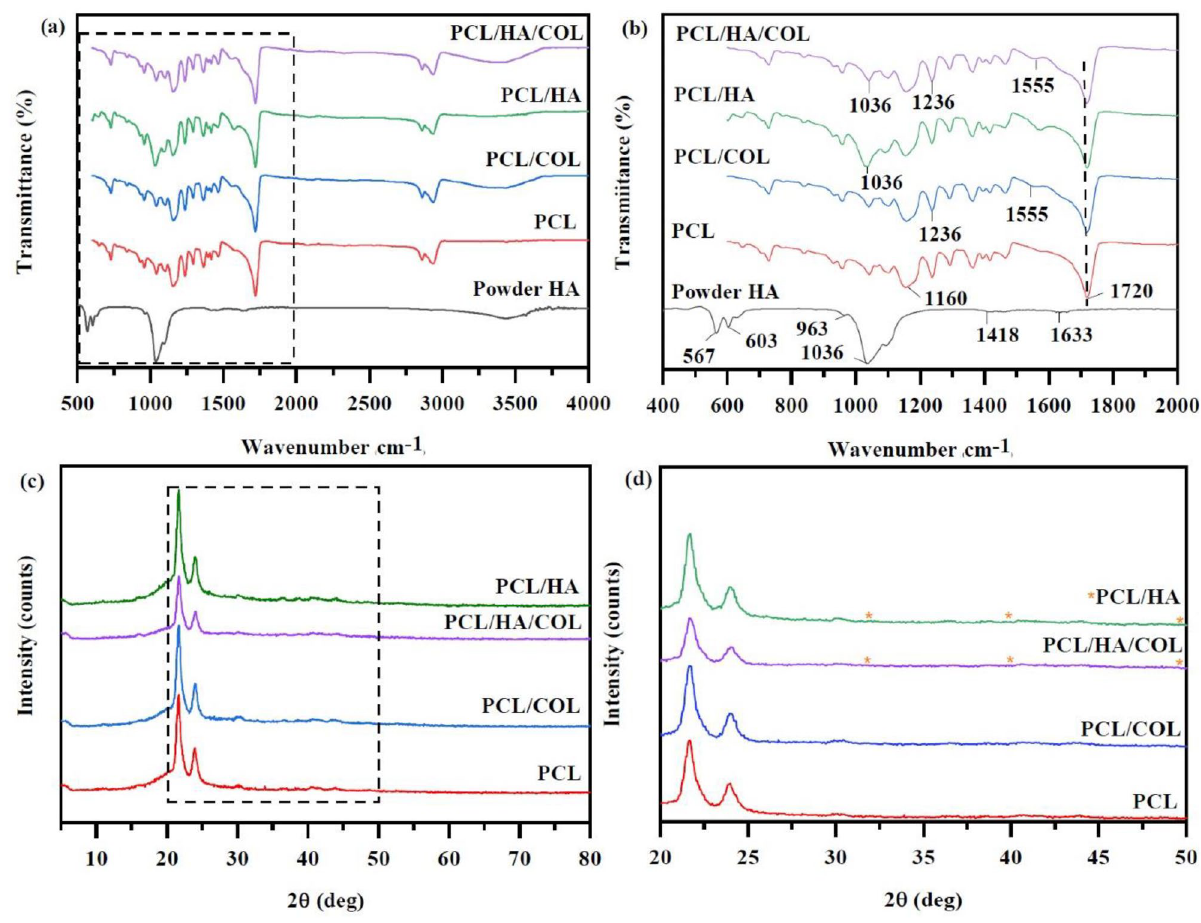
Figure 1. ( a , b ) ATR-FTIR spectra of powder HA, PCL scaffold, COL and HA-coated PCL scaffolds, and ( c , d ) The X-ray diffraction (XRD) spectra of PCL and composite